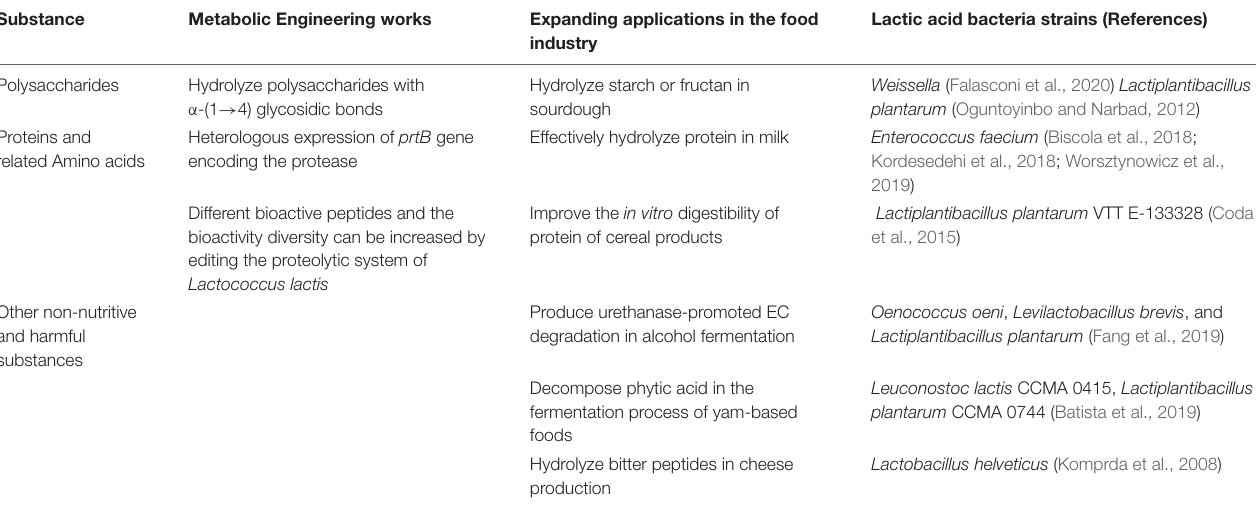
TABLE 1 | The degradation of macromolecular substances in food by lactic acid bacteria.